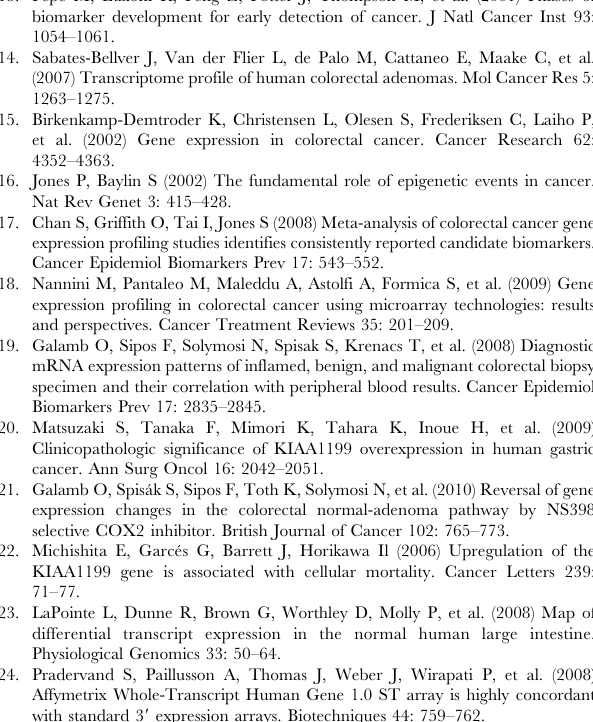
Table S6 Confidence intervals of sensitivity and specificity for each validated up-regulated probeset in colorectal neoplasia (19 adenomas + 19 cancers) relative to 30 normal colon tissue specimens (validation data). Note that sensitivity and specificity calculations are estimated based from the mid-point of ROC curves (approximate inflection point) and are included for comparison purposes only. Table S7 Confidence intervals of sensitivity and specificity for each validated down-regulated probeset target in colorectal neoplasia (19 adenomas + 19 cancers) relative to 30 normal colon tissue specimens. Note that sensitivity and specificity calculations are estimated based from the mid-point of ROC curves (approximate inflection point) and are included for comparison purposes